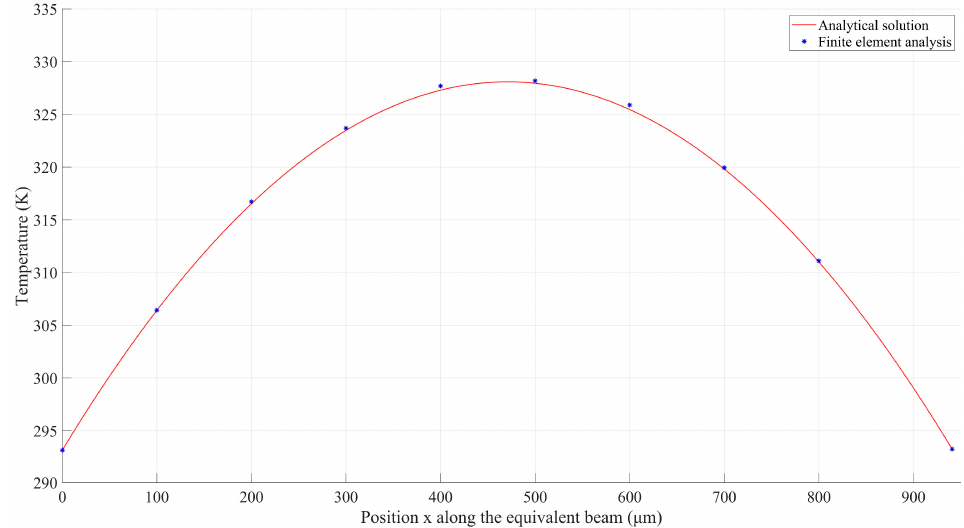
Figure 6. Comparison of temperature distributions between the analytical solution and finite element model when a voltage of 0.04 V was applied.